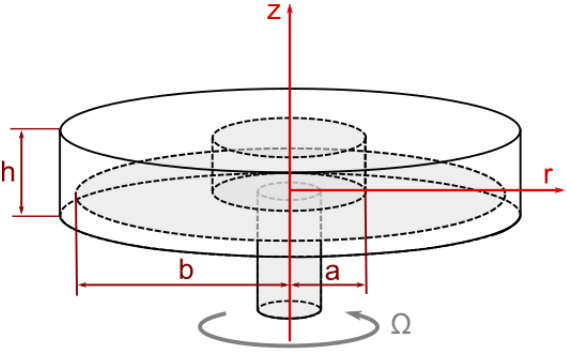
Figure 3. Designation of variables for characterization of the flow in sidewall gap.